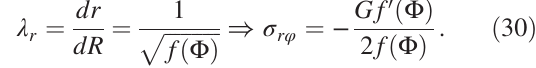
FIG. 5. Similarity solutions for symmetric corners obtained from Eqs. (24) and (29), all with θ effect, the shear stress vanishes at the interface, and one recovers the Singh-Pipkin solution [49]. (b),(c) The Shuttleworth effect induces Marangoni stresses, giving positive (b) or negative (c) elastic shear stress at the interface, the direction indicated by the